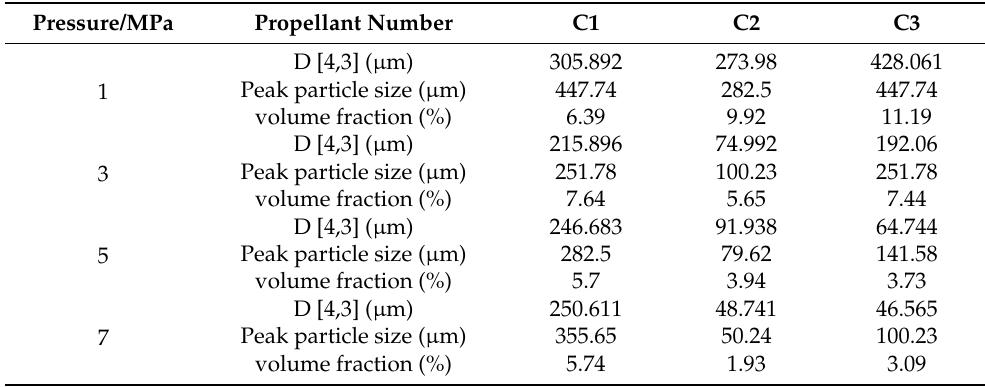
Table 2. CCPs peak particle size and D [4,3] at different